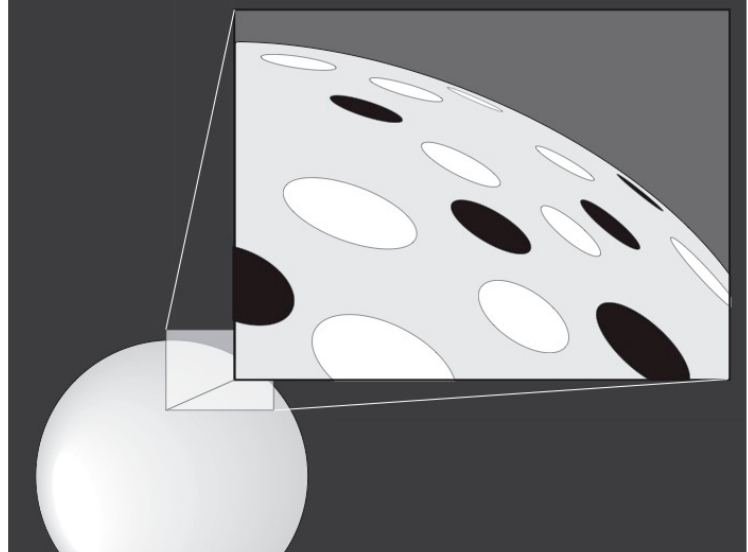
Figure 2. An external view of the expanding multi-layered structure of academic knowledge in natural sciences.